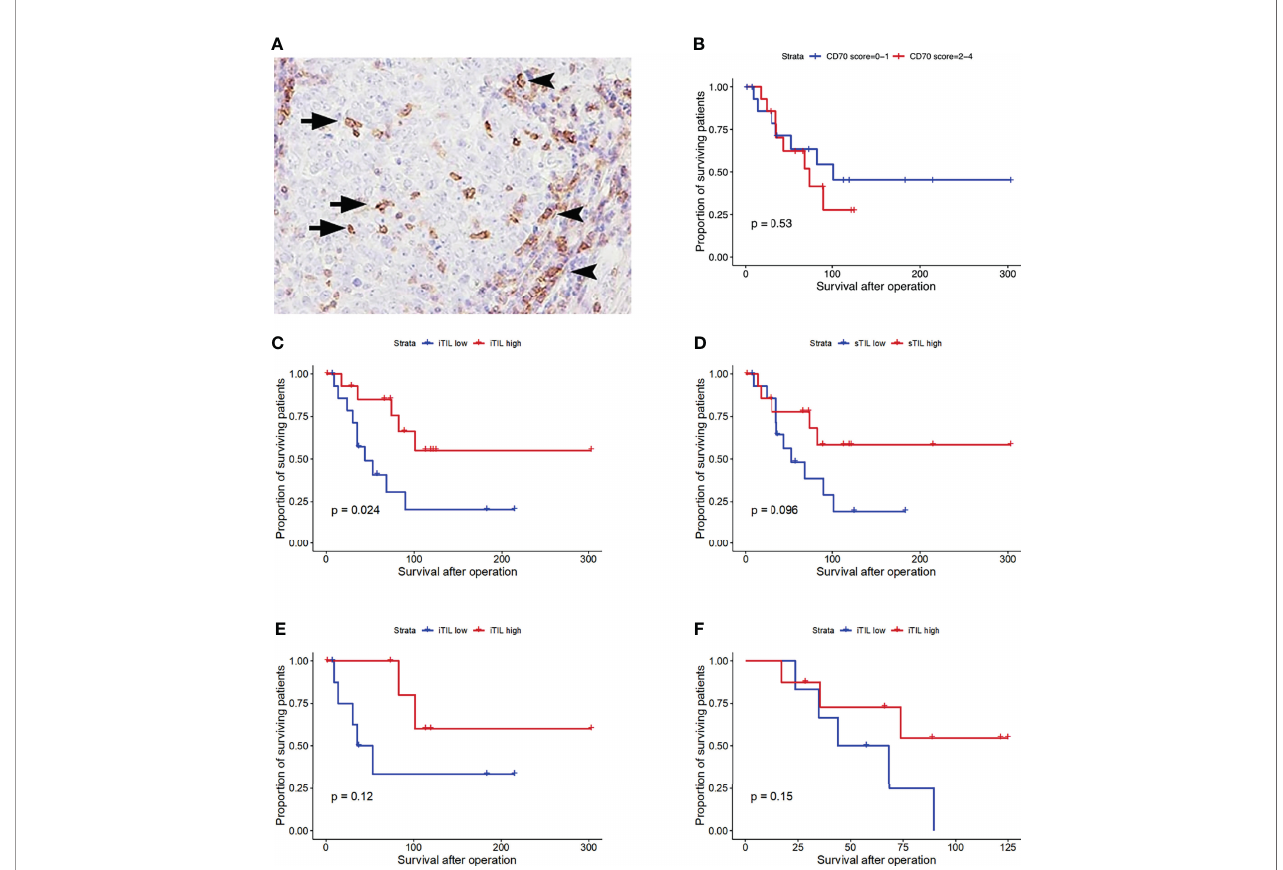
FIGURE 3 | CD27 staining of thymic squamous cell carcinoma (A) . CD27-positive intratumoral tumor-in fi ltrating lymphocytes (iTIL, arrow) and stromal TIL (sTIL, arrowhead). Overall survival of patients with thymic carcinoma according to the CD70 expression status (B) , the number of CD27-positive iTIL (C) and sTIL (D) . Strati fi ed survival curve in the CD70-low group (E) and CD70-high group (F) . x-axis: